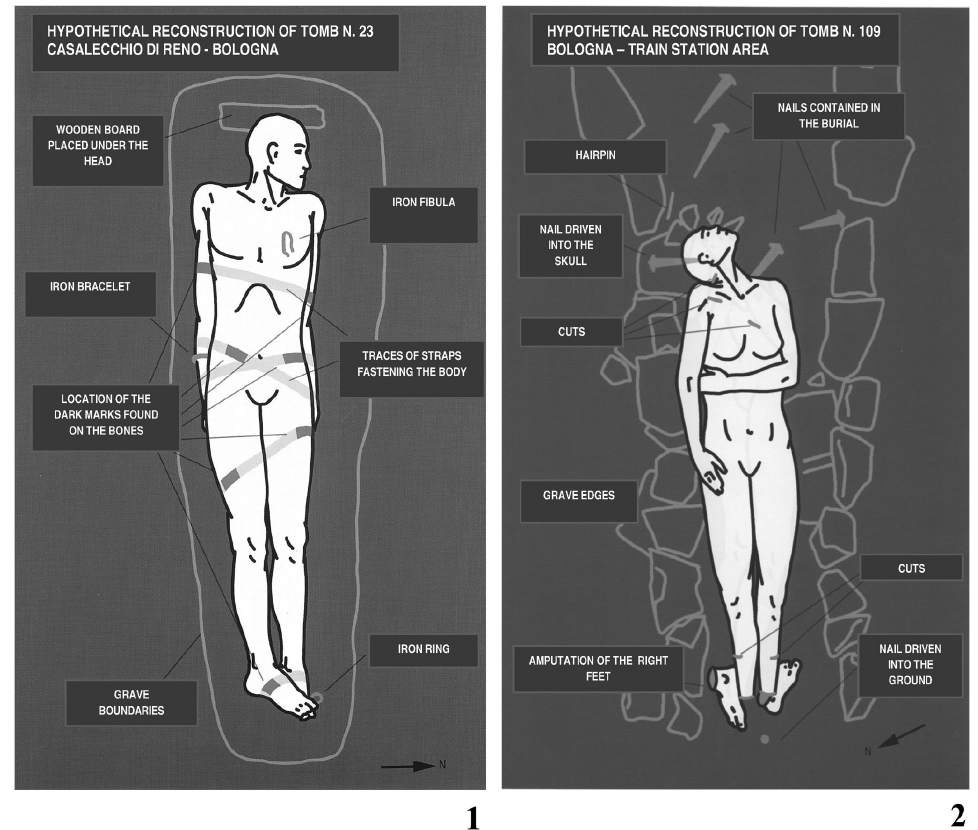
Figure 2: Reconstructions of anomalous graves from the Aemilia region. 1) Casalecchio di Reno, tomb no. 2, fastened individual (after Pancaldi and Raggi 2010: 83); 2) Bologna, tomb no. 109, nailed individual (after Cornelio-Cassai and Cavallari 2010: